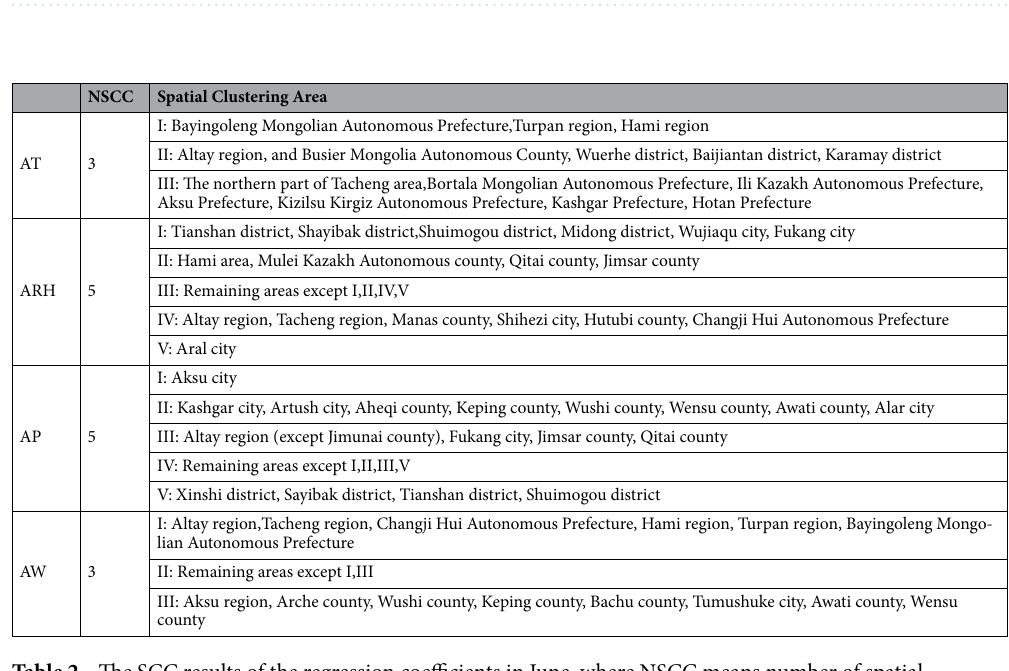
Table 2. The SCC results of the regression coefficients in June, where NSCC means number of spatial clustering categories.